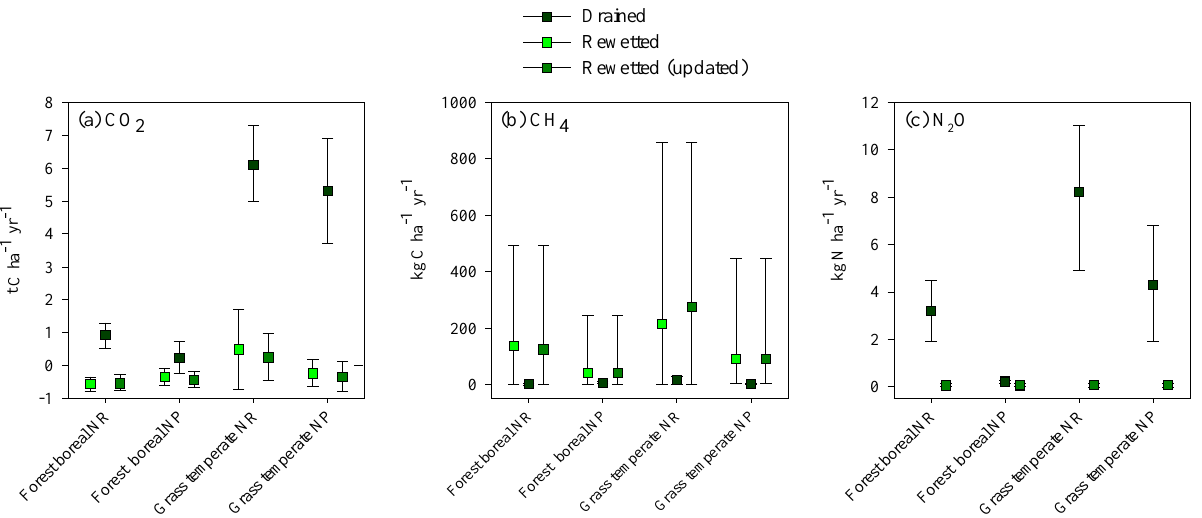
Figure 6. Mean annual (a) carbon dioxide (CO 2; t C ha -1 yr -1 ), (b) methane (CH 4; kg C ha -1 yr -1 ) and (c) nitrous oxide (N 2 O; kg N ha -1 yr -1 ) emission factors for drained (values taken from IPCC 2014a, Chapter 2) and rewetted (presented using the derived value from the Wetlands Supplement and an updated value that incorporates the new data published post 2013) organic soils for selected land use categories as defined by IPCC (2014a). Error bars represent the 95 % confidence intervals. Positive values indicate annual emissions and negative values indicate annual removals. NR = nutrient rich, NP = nutrient